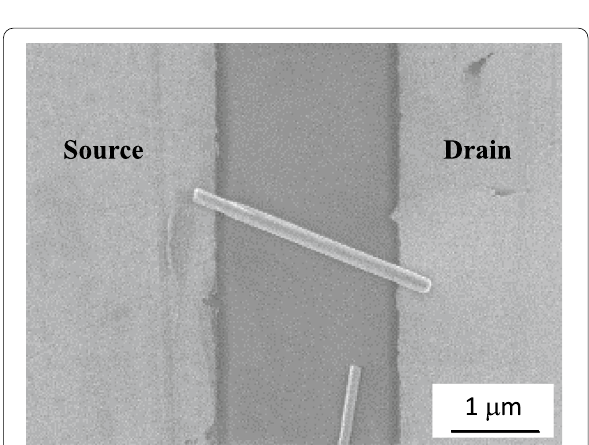
Fig. 3 I–V curves of the individual ZnO NW device with voltages of 1, 2, and 3 V applied to the drain electrode in the DEP alignment process